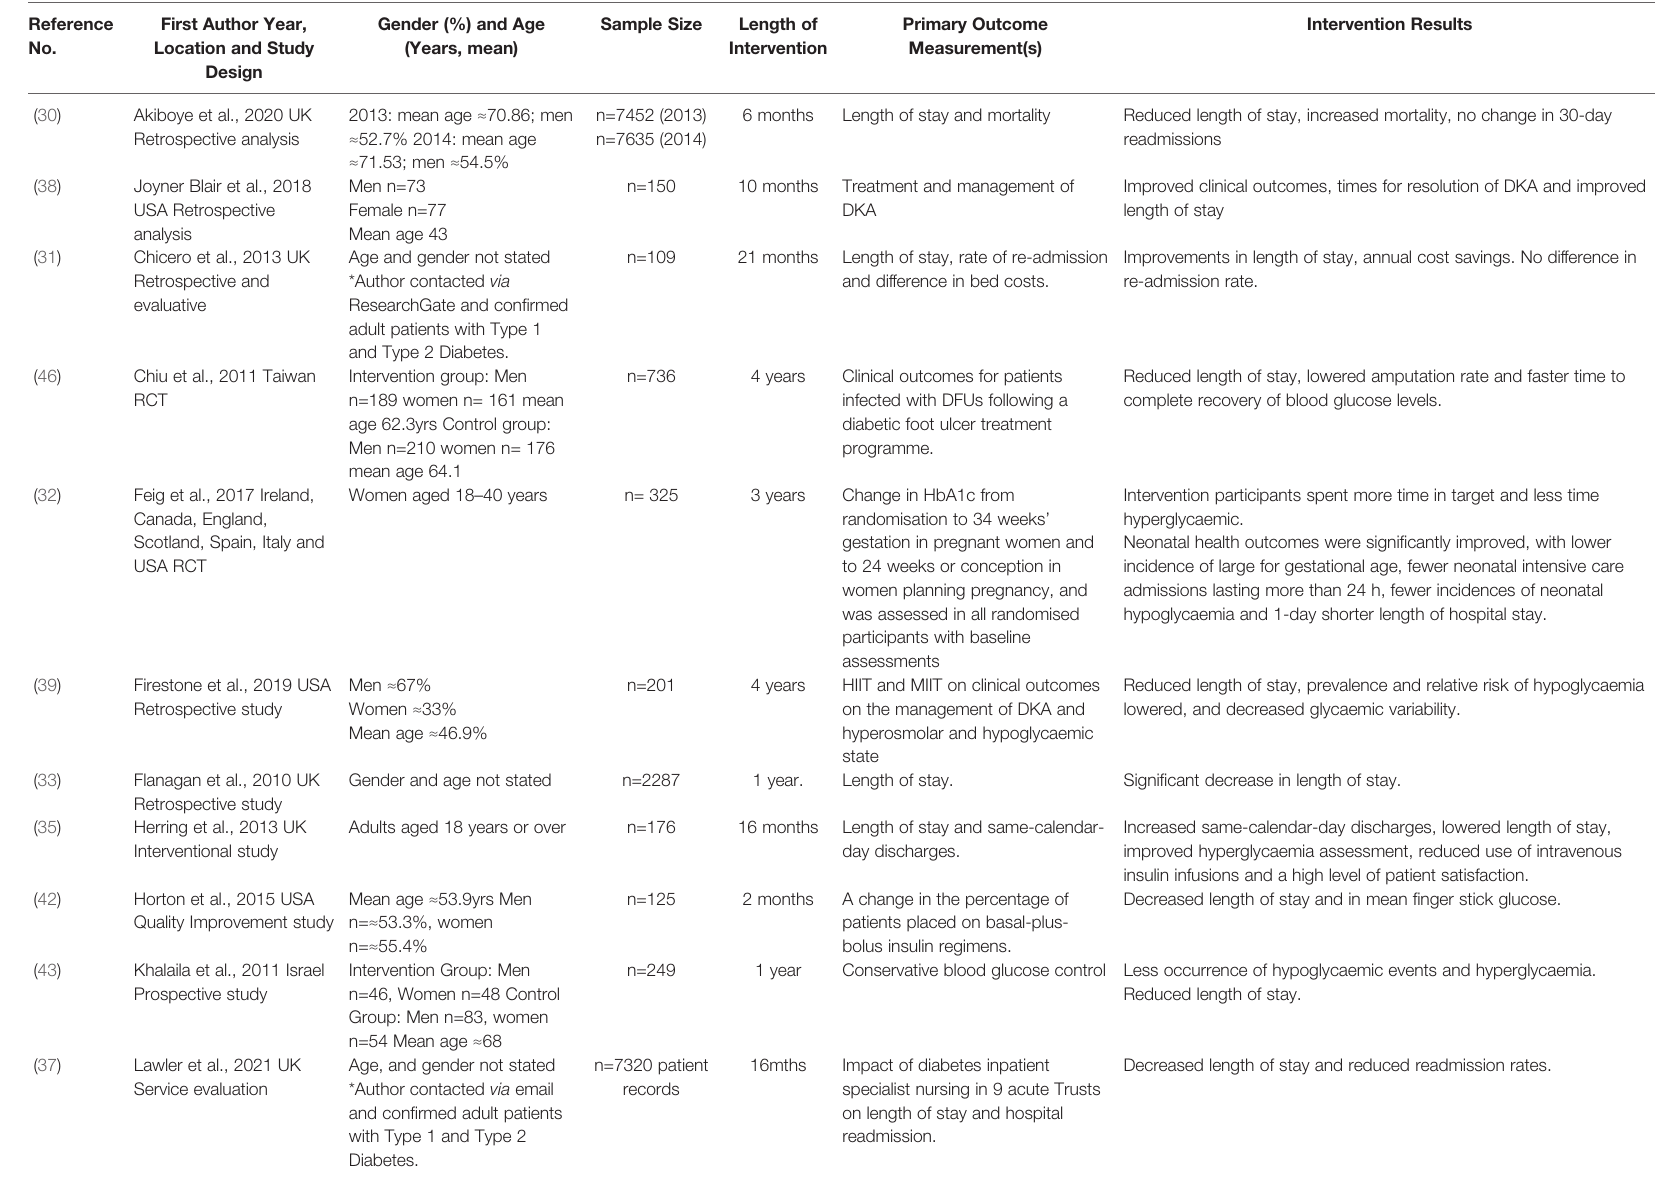
TABLE 1 | Intervention studies with improved clinical outcomes and reduced length of hospital stay. Reference